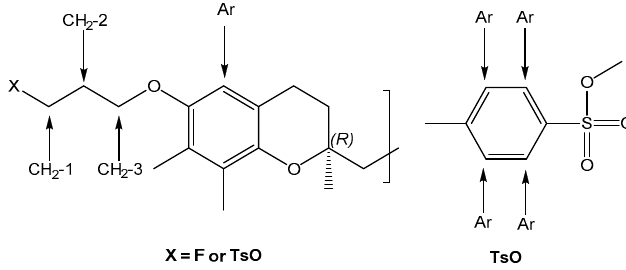
Figure 5. NMR numbering of target compounds F- γ -T-3 and [ 18 F]F- γ -T-3.